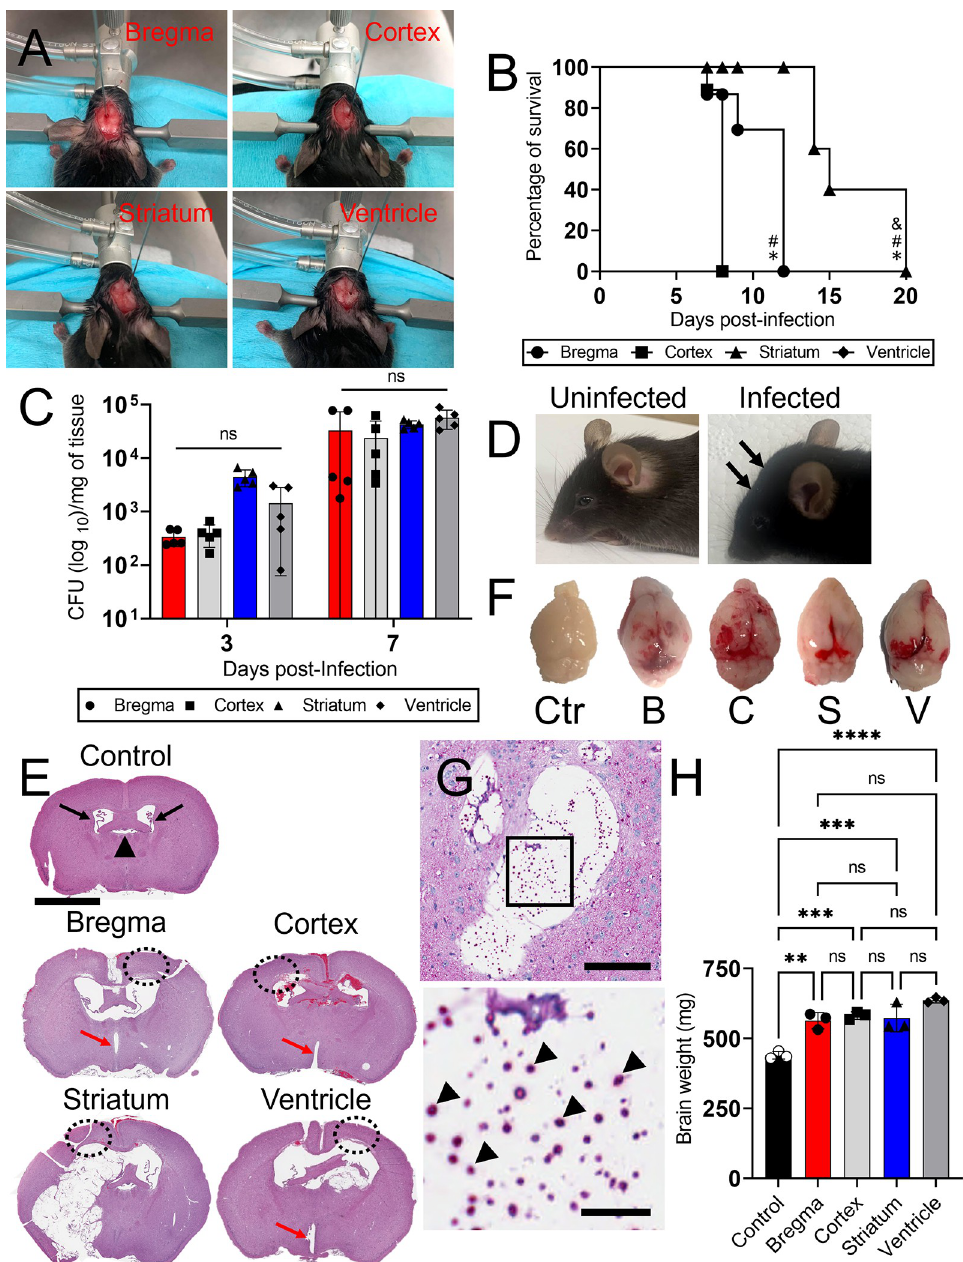
Fig 1. Intracerebral (i.c.) Cryptococcus neoformans infection of C57BL/6 mice in specific brain regions causes hydrocephalus and subarachnoid hemorrhage exacerbating mortality. (A) C57BL/6 mice of 6–8 weeks old were i.c. infected with a single inoculum of 10 4 C . neoformans strain H99 cells in either bregma, cortex, striatum (basal ganglia), or ventricle after a stereotaxic surgery. (B) Survival differences of C57BL/6 mice infected with 10 4 fungi ( n = 10 mice per group) in bregma (circle), cortex (square), striatum (triangle), or ventricle (diamond). The survival curves for cortical and ventricular infections are overlapped. Symbols ( � , #, and &) indicate P value significance ( P < 0.05) calculated by log rank (Mantel-Cox) analysis. � , #, and & indicate significantly longer survival than in the cortex-, ventricle-, and bregma- infected groups, respectively. (C) Fungal burden in whole brain tissue (numbers of colony forming units (CFU)/ milligram (mg) of tissue) collected from bregma-, cortex-, striatum-, and ventricle-infected mice with 10 4 cryptococci ( n = 5 per group) 3- and 7-days post-infection (dpi). (D) Photograph of a mouse infected with C . neoformans H99 in the striatum of the basal ganglia showing signs of hydrocephalus (right) including bulging of the forehead (black arrows). A picture of a healthy uninfected mouse (left) is shown for comparison. These animals were euthanized 20-dpi. (E) Representative brain coronal histology sections of uninfected control and bregma-, cortex-, striatum-, and ventricle-